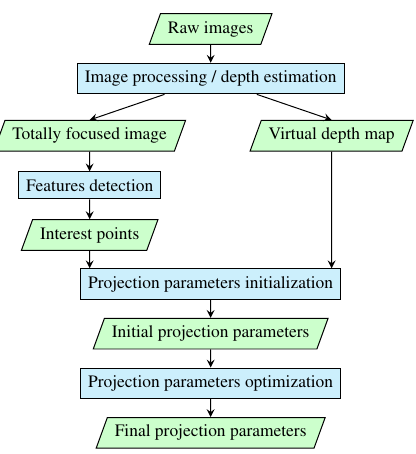
Figure 4. Flow chart of the calibration process.